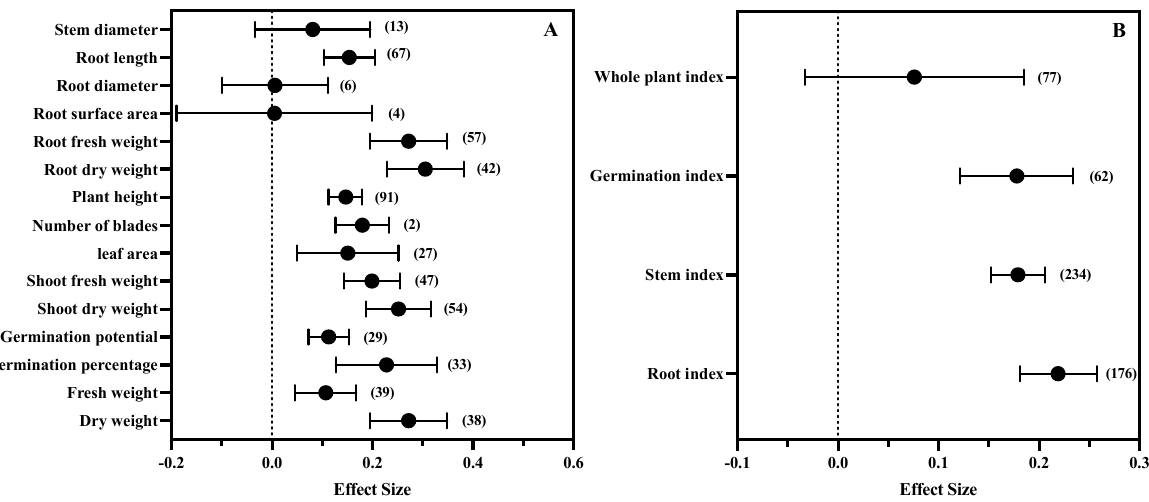
Figure 3. The difference in response of growth parameters. ( A ) Growth parameters; ( B ) classification of growth parameters. The symbol represents the effect size, and the bars show the 95% bootstrapped confidence intervals. The values in the parentheses show the number of observations.